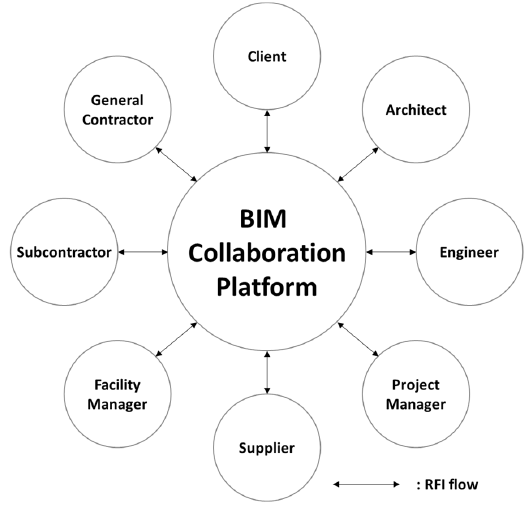
Figure 1. RFI flow in BIM collaboration platform.